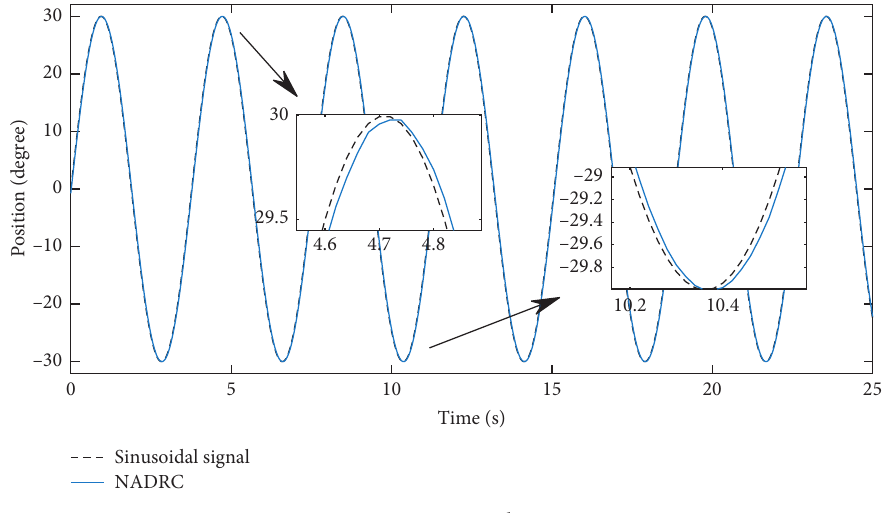
Figure 13: Position tracking curve.